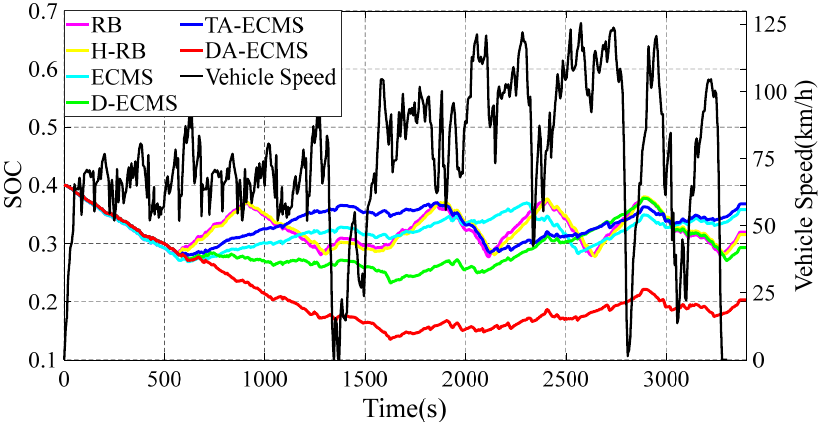
Figure 11. Variation curves for the vehicle speed and the SOC under different strategies.